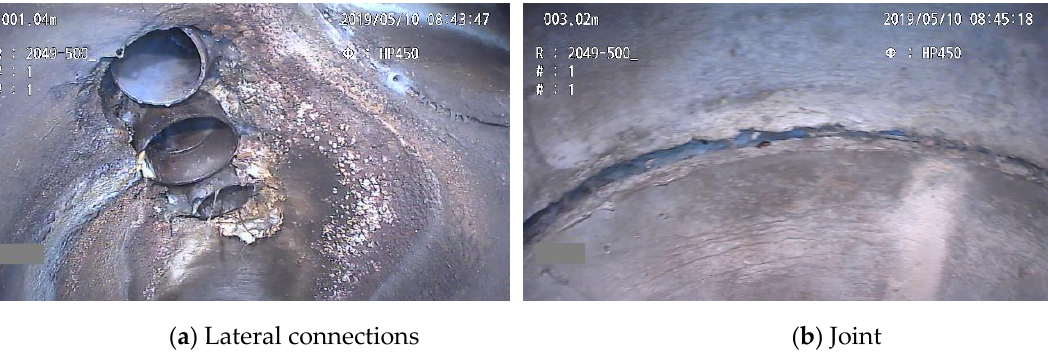
Figure 4. Lateral connections ( a ) and joint ( b ) in CCTV footage.